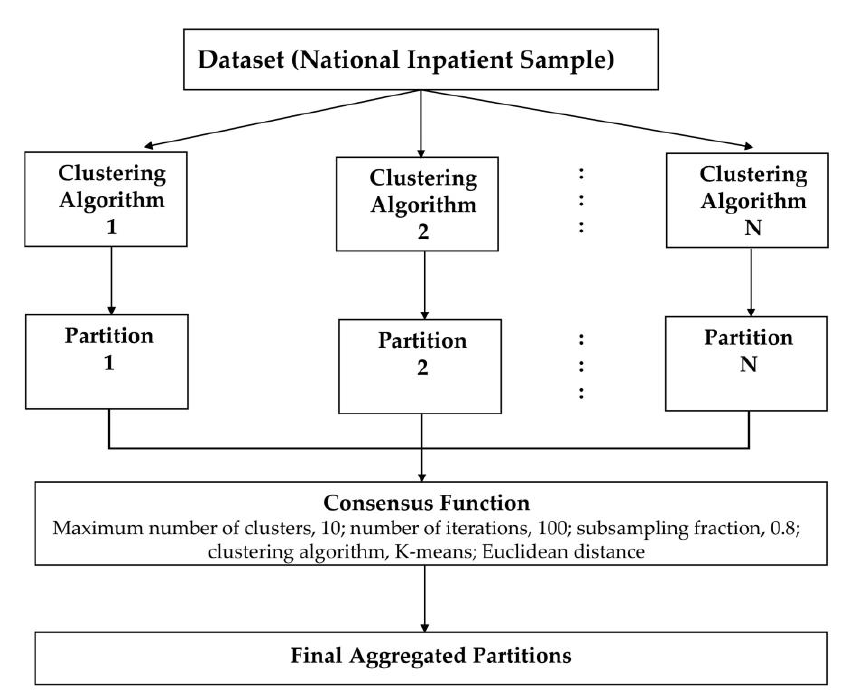
Figure 1. Workflow of Consensus Clustering.